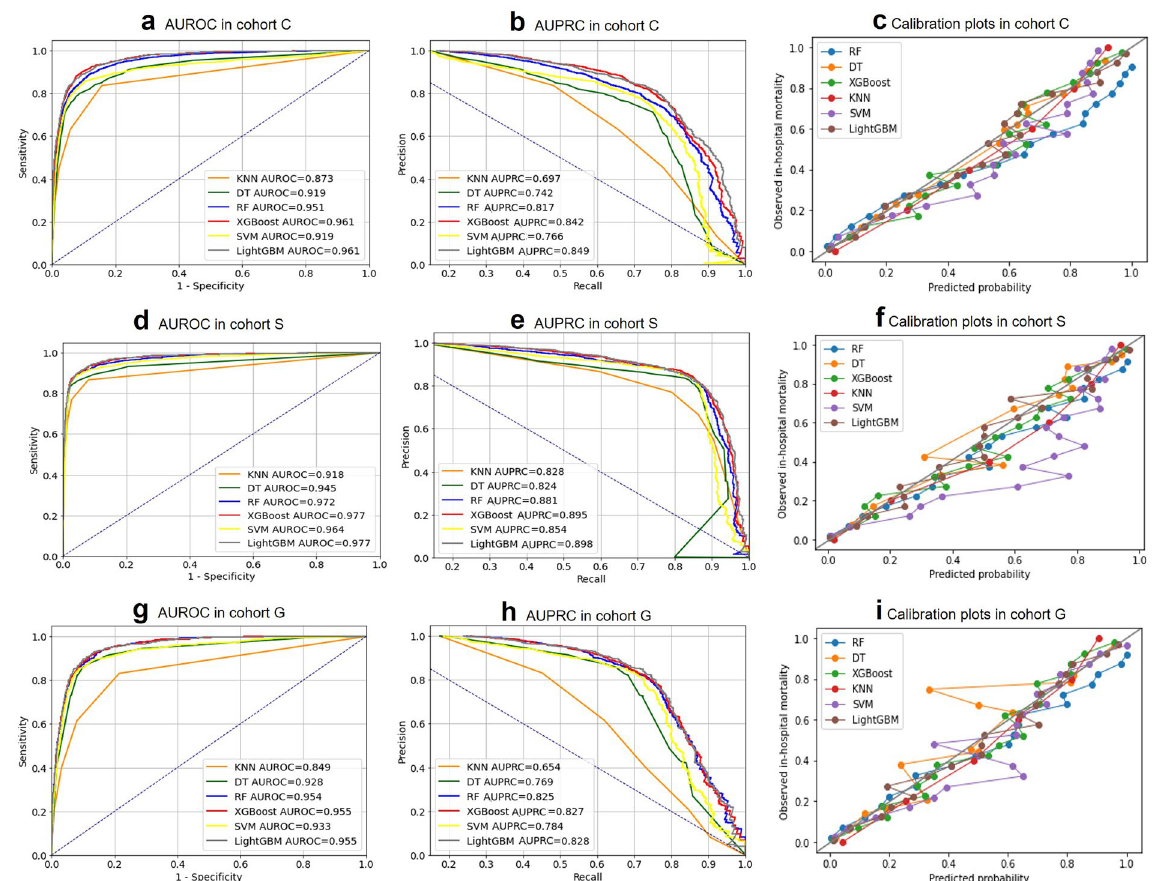
Figure 2. Comparison of machine learning-based in-hospital mortality prediction models. AUROC area under the receiver operating characteristic curve, AUPRC area under the precision-recall curve, KNN K-nearest neighbor, DT decision tree, RF random forest, XGBoost eXtreme gradient boosting, LightGBM light gradient boosting, SVM support vector machine. The calibration plots show the agreement of between